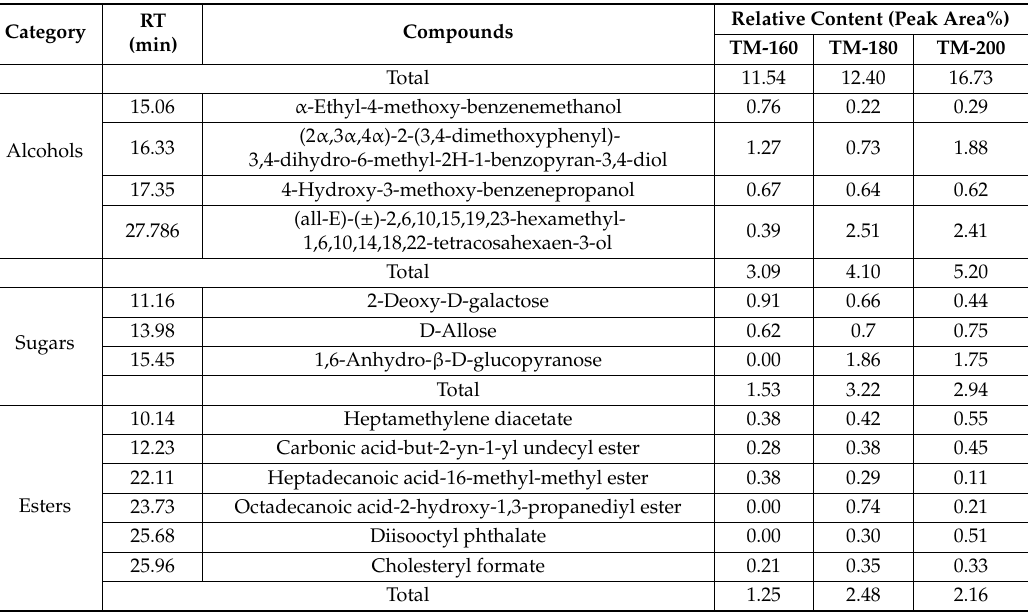
Table S1: The P-level analysis of data from the physical-mechanical properties, Table S2: Mean and standard deviation values of mass loss of thermal modified wood, Table S3: Mean and standard deviation values of crystallinity index (CrI) of the control and thermal modified wood, Table S4: Mean and standard deviation values of ultimate analysis of the control and thermal modified wood, Table S5: Mean and standard deviation values of the EMC and ASE of the control and thermal modified wood, Table S6: Mean and standard deviation values for the MOE and MOR of the control and thermal modified wood, Table S7: Mean and standard deviation values of the surface color of the control and thermal modified